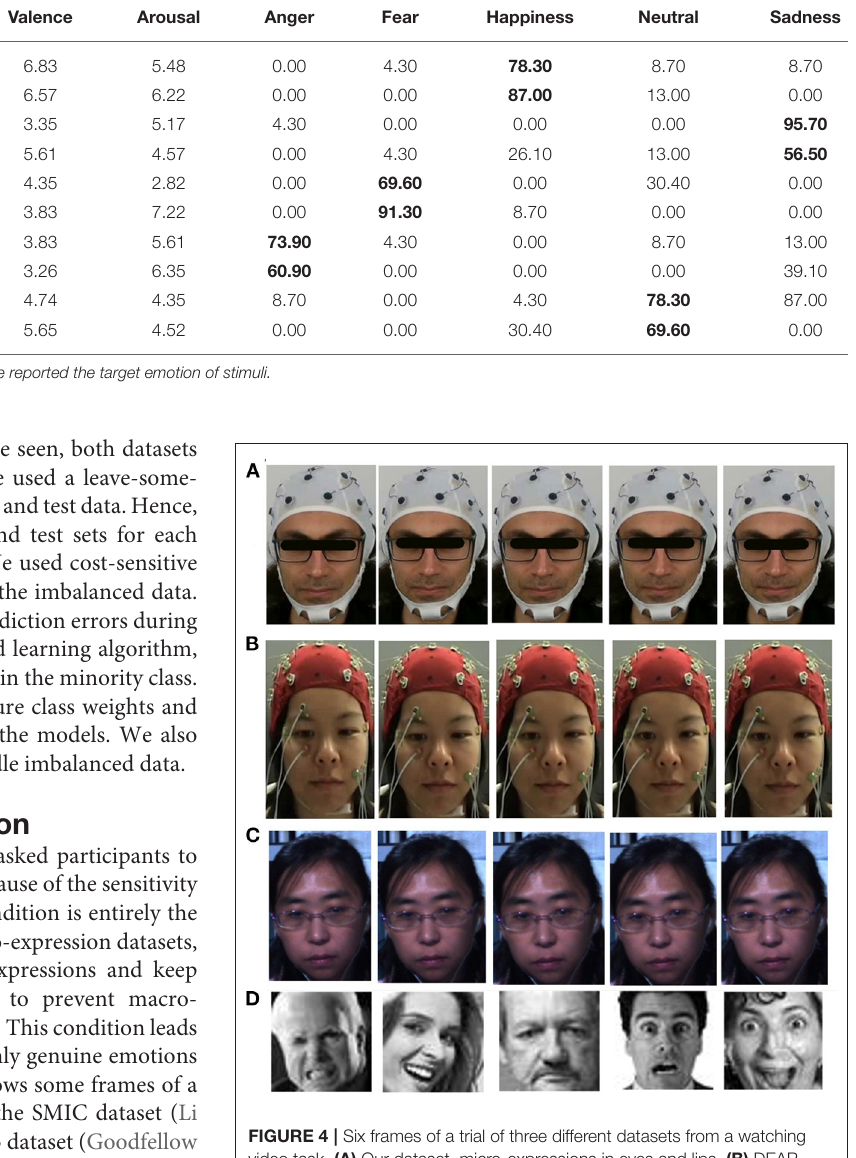
structure of model. FER2013 is a large-scale dataset